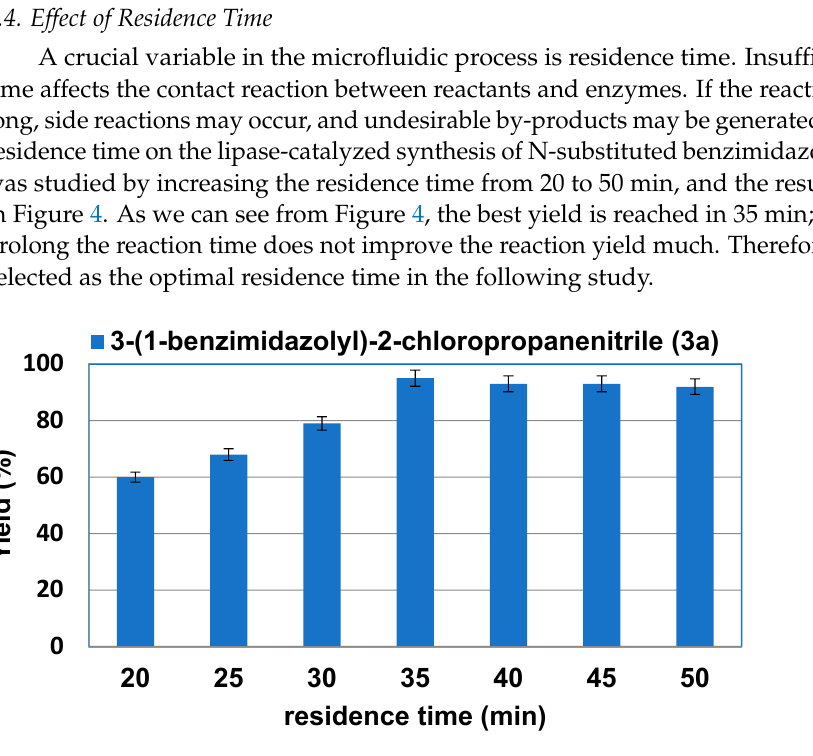
Figure 3. The influence of reaction temperature on the synthesis of N-substituted benzimidazole derivatives catalyzed by lipase TL IM from Thermomyces lanuginosus in continuous-flow microreactors.